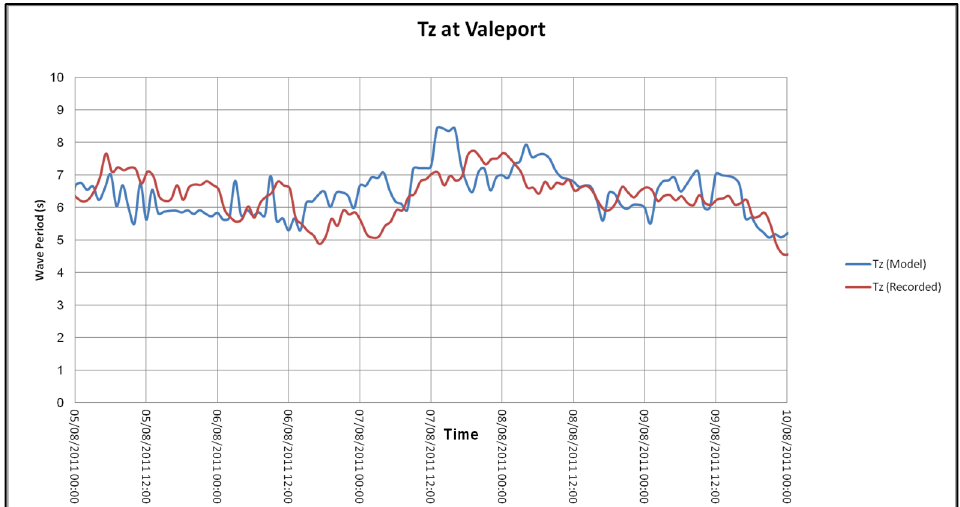
Figure 6. Modelled vs. recorded Tz in Dingle Bay.